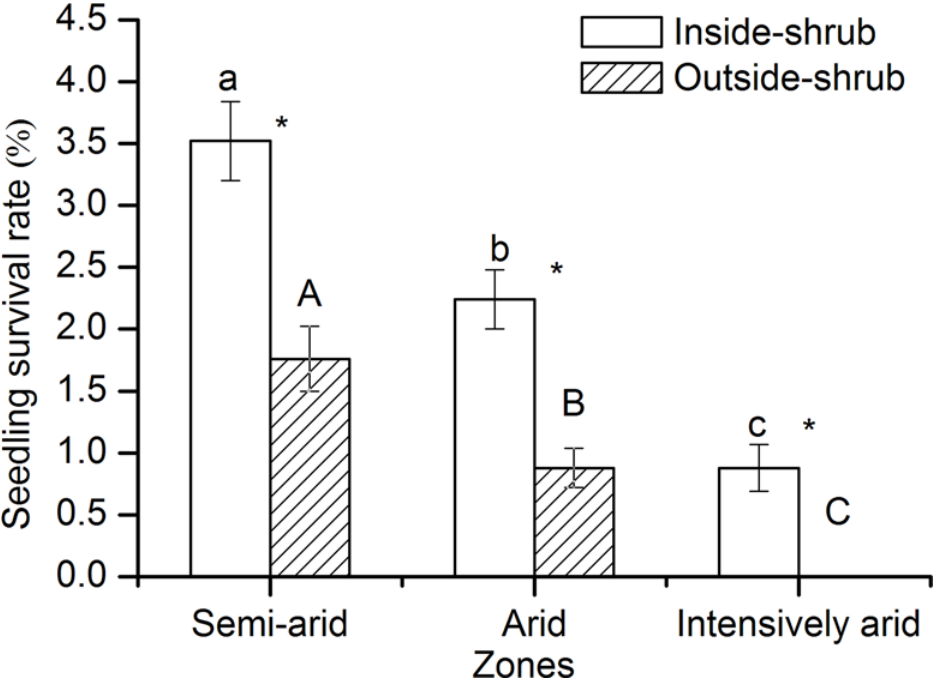
(inside-shrub: lowercase; outside-shrub: uppercase) indicate significant differences in the means between zones (Tukey HSD tests, P < 0.05). Within each zone, asterisks indicate significant differences in the means between inside-shrub and outside-shrub (t-test, P < 0.05).